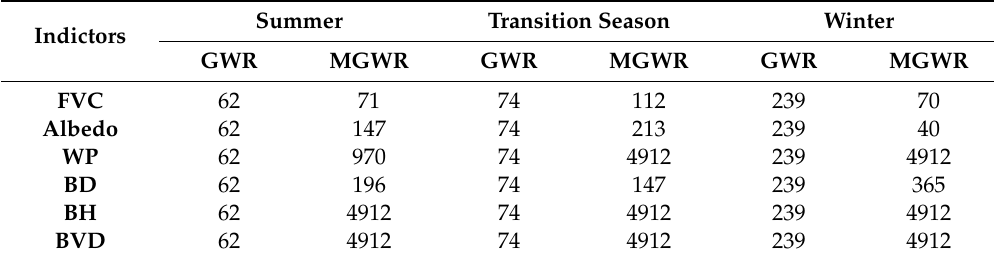
Table 5. Optimal bandwidths identified by GWR and